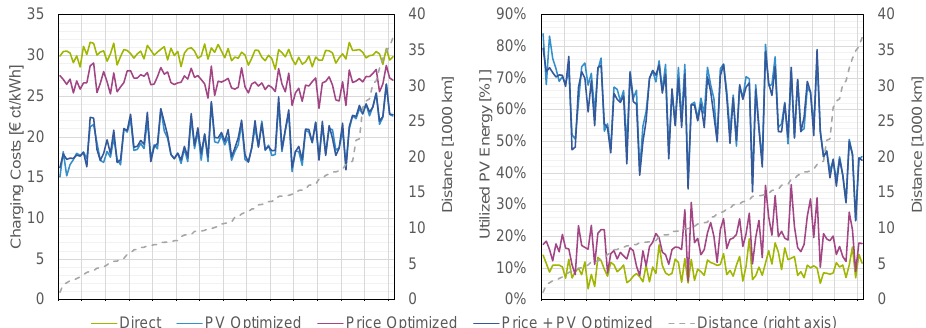
Figure 17. ( Left ): Charging costs in EUR ct/kWh for all charging configurations sorted by ascending driven distance. ( Right ): Percentage of the PV -utilized energy out of the total charging load for all charging